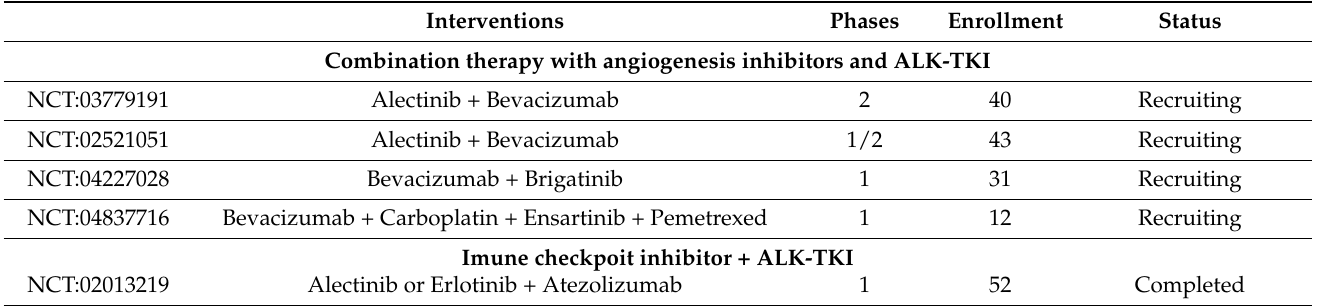
Table 7. Recent and ongoing clinical